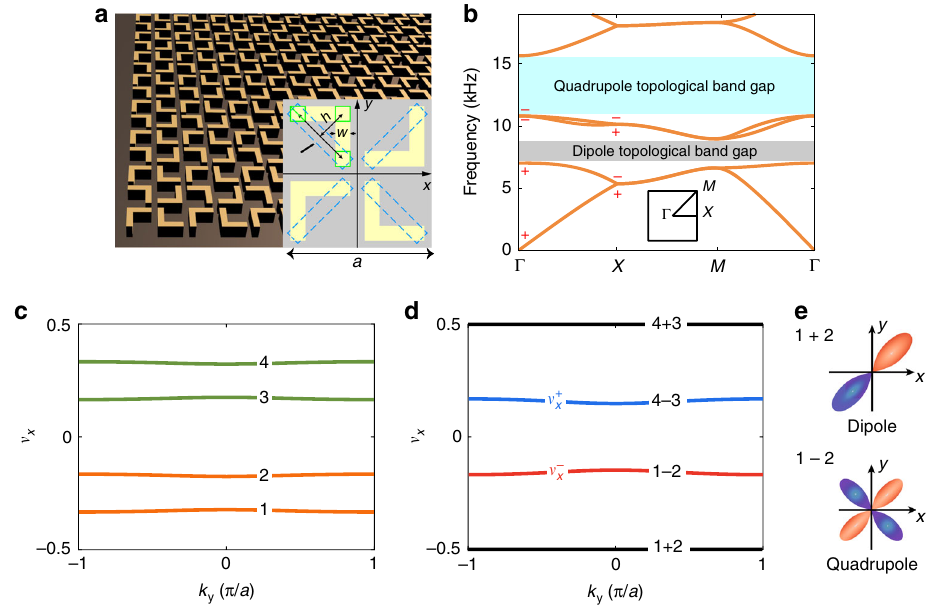
Fig. 1 Symmetry-protected hierarchy of anomalous topological multipoles in nonsymmorphic sonic crystals. a A bird ’ s-eye view of the 2D nonsymmorphic sonic crystal cladded by plastic boards from below and above (not shown). The inset illustrates the unit-cell structure with four arch- shaped scatterers made of photosensitive resin (an acoustically rigid material). b Acoustic bands and the hierarchy of multipole topological band gaps. The dipole and (anomalous) quadrupole are quantized and protected by the glide symmetries in the p 4 g group. Inset: Brillouin zone. Symbols + / − represent even/odd parity, respectively, at the Γ and X points in the Brillouin zone. c Gapped and nondegenerate Wannier bands for the anomalous quadrupole topological gap. d Wannier bands for the sum ( “ 1 + 2 ” and “ 4 + 3 ” ) and difference ( “ 1 − 2 ” and “ 4 − 3 ” ) sectors. e Schematic illustration of the linear combinations of the Wannier orbits in different sectors ( “ 1 + 2 ” and “ 1 − 2 ” ), which respectively yield the dipole topology and the anomalous quadrupole topology. Unit-cell geometry parameters are h = 0.21 a , l = 0.42 a , w = 0.1 a , and a = 2 Fig. 1d, e). Interestingly, the difference sector has gapped Wan- nier bands (see “ 1 − 2 ” and “ 4 − 3 ” in Fig. 1d, e) and quantized